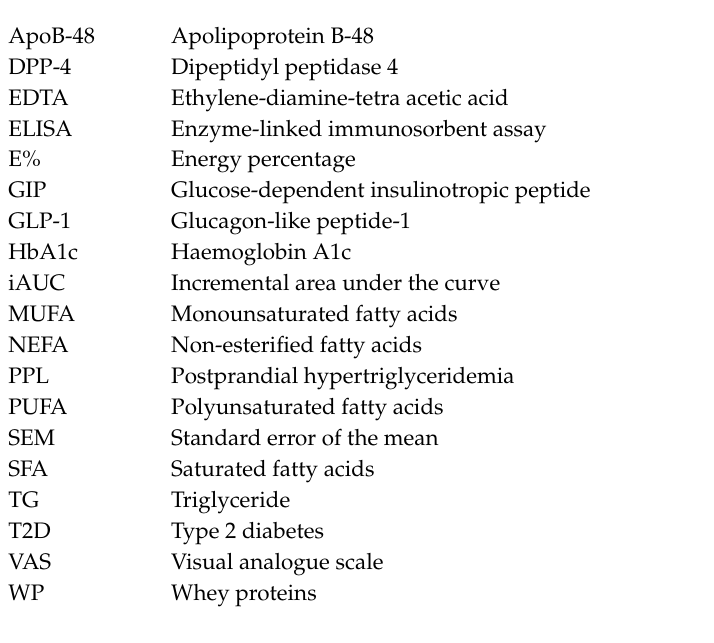
Table S1: Means (95%-CI) of appetite parameters. Subjects with ( n = 12) and without type 2 diabetes (T2D) ( n =